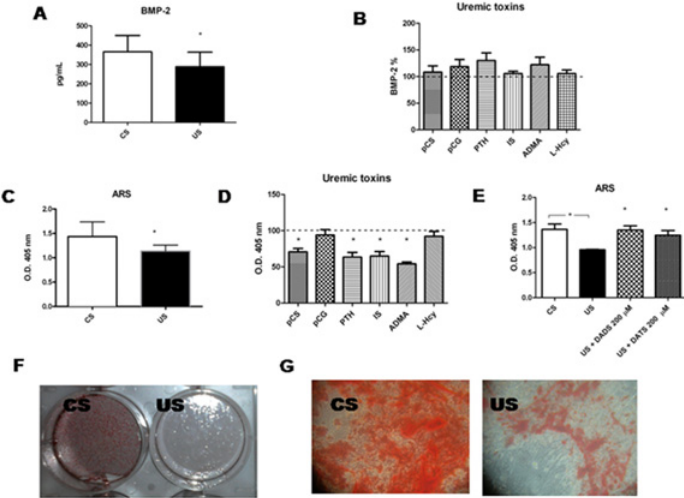
Figure 5. Levels of BMP-2 and ARS in hMSC medium in response to serum from uremic patients or selected uremic toxins and effect of H 2 S donors, during osteogenic differentiation. BMP-2 levels in uremic serum (US) treated hMSCs (panel A) or upon treatment with selected toxins added to control serum (CS) (panel B), and ARS in CS or US treated hMSCs (panel C) or upon treatment with selected toxins (pCS, p-cresylsulfate; pCG, p-cresylglucuronide; PTH, parathyroid hormone; IS, indoxyl sulfate; ADMA, asymmetric dimethylarginine; Hcy, homocysteine) added to NS (panel D) are shown. Effects of H 2 S donors DADS and DATS on ARS in US treated cells (panel E). Examples of ARS stain in hMSCs treated with CS or US, as culture well picture (panel F) and as microscopy images (panel G). * p < 0.05.